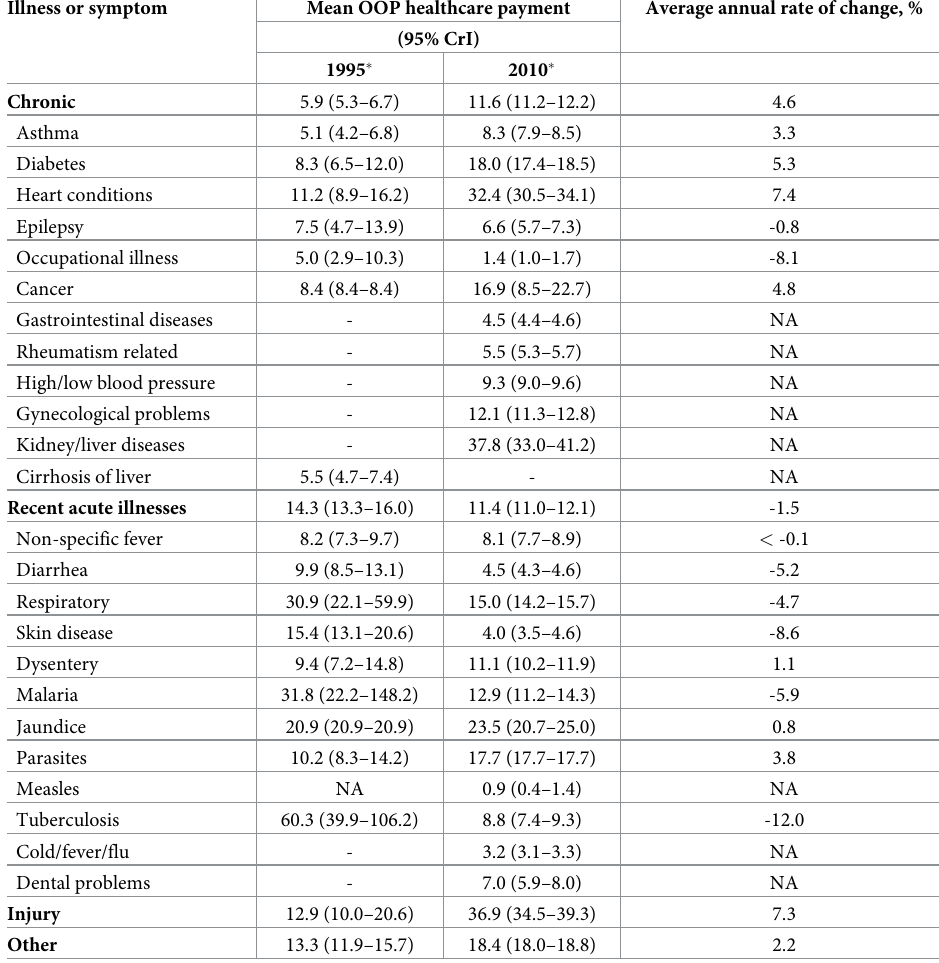
Table 4. Disease-specific out-of-pocket healthcare payment in Nepal